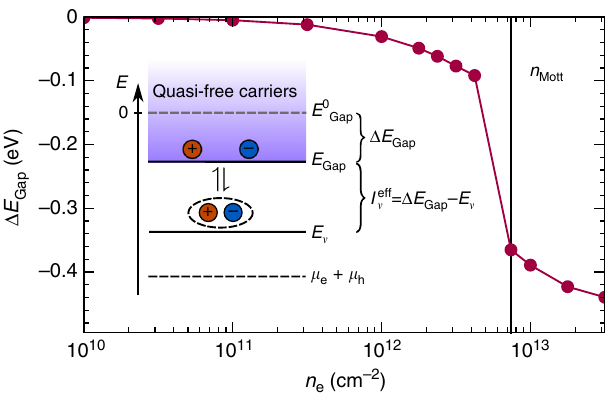
Fig. 5 Ionization equilibrium and quasi-particle band-gap renormalization. The band-gap renormalization Δ E Gap for increasing excitation density is depicted for spin-up carriers at the K -point in WS 2 on SiO 2 substrate at T = 300 K. The vertical black line marks the Mott transition. The inset is a gap at zero excitation density E 0 , which is conventionally set to zero Gap energy. All quantities including the bound-state energies E ν and the sum